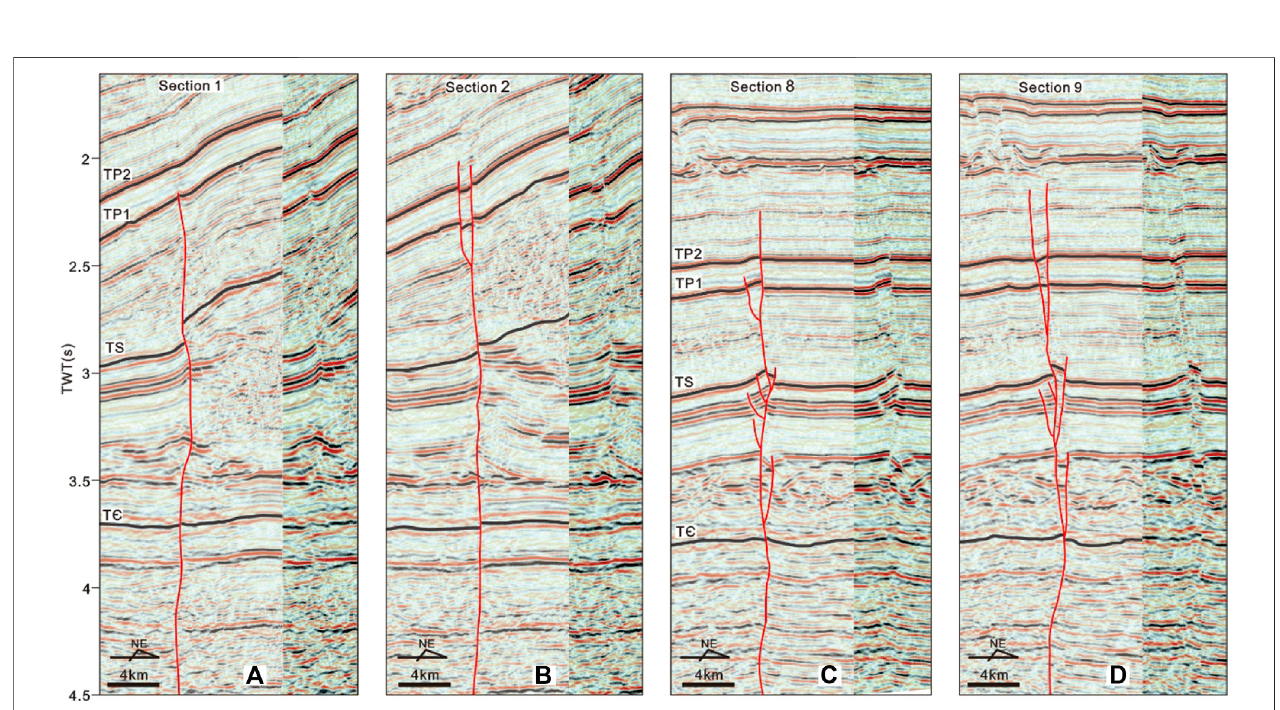
FIGURE 6 | Fault interpretations of cross Section 1 (A) , Section 2 (B) , Section 8 (C) , Section 9 (D) . The uninterpreted right images are shown for comparison and cropped as the central part of the left images where fault zones occur. See Figure 1D for location. TWT = two-way time.